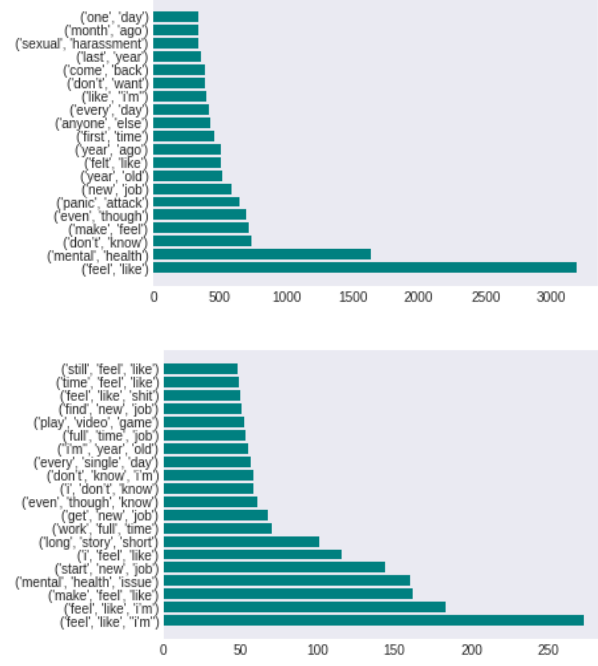
Figure 1. N-gram analysis for our Reddit